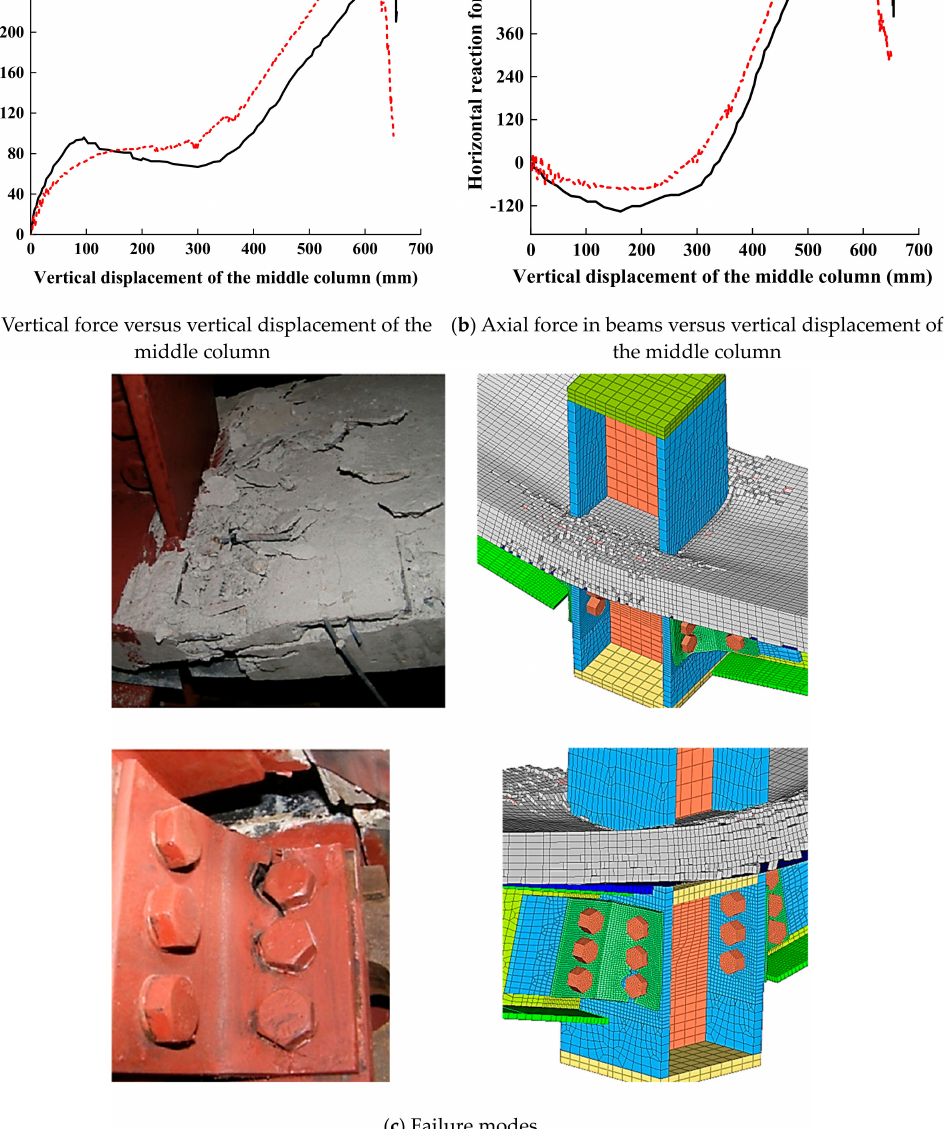
Figure 9. Comparison between simulation and experimental results of I-W-MT in Yang el al.